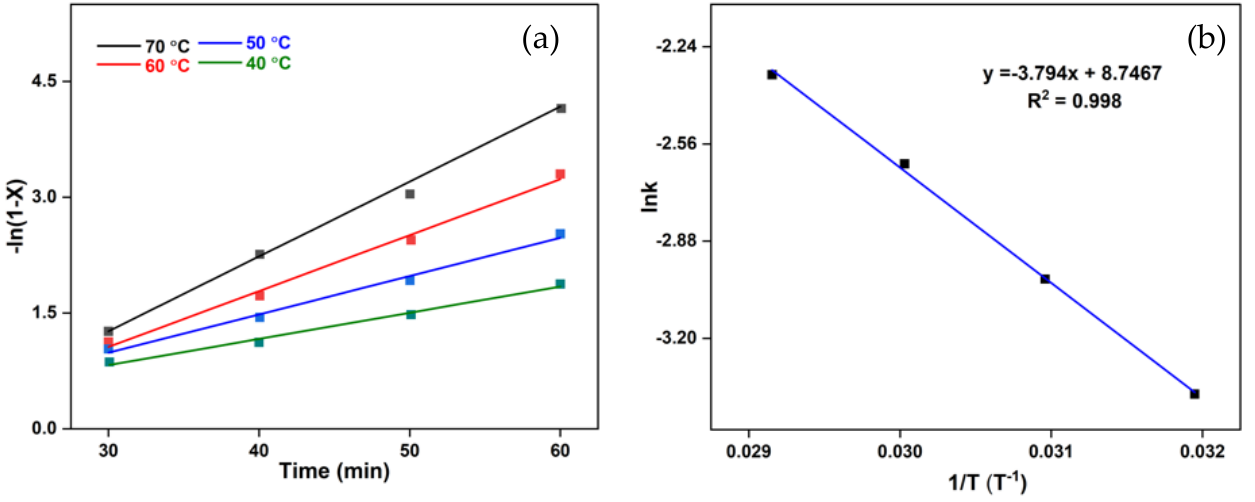
Figure 13. ( a ) − ln(1 − X ) vs. time ( X = soybean yield) and the relevant Arrhenius plot of ( b ) ln k vs. 1/ T